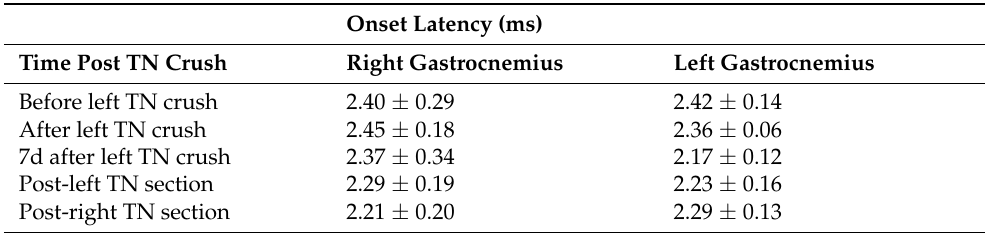
Figure 4. Evolution of gastrocnemius MEP following tibial nerve crush and section: ( A ) Representa- tive traces of gastrocnemius motor evoked potentials (MEP) of before and after left tibial nerve (TN) crush, 7 days post-crush and post-left and -right TN section in right and left gastrocnemius muscles. ( B ) Gastrocnemius MEP quantification for the different time-points. * vs. Before left TN crush group for left gastrocnemius (one-way repeated measures ANOVA, Holm–Sidak method, p < 0.001); # vs. post-left TN crush group for right gastrocnemius (one-way repeated keasures ANOVA, Holm–Sidak method, p = 0.005). † vs. Post-left TN section group for right gastrocnemius (One-Way Repeated Measures ANOVA, Holm–Sidak method, p < 0.001). Table 2. Evolution of onset latency measured for right and left gastrocnemius following left tibial nerve (TN) crush and